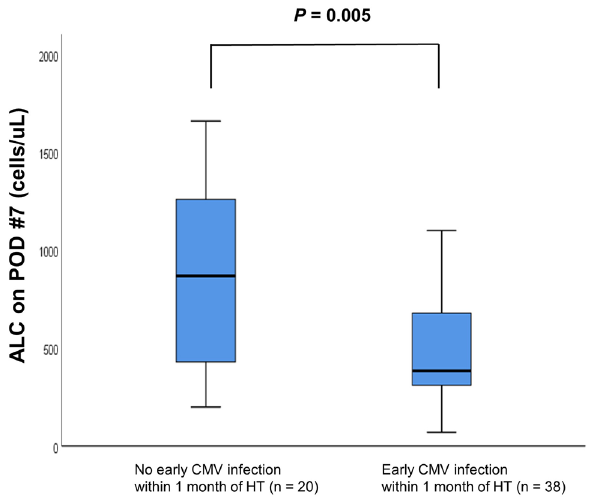
Figure 2. Distribution of ALC on postoperative day 7 in patients who had early CMV infection within one month after HT (n = 38), and those who did not (n = 20). ALC = absolute lymphocyte count, CMV = cytomegalovirus, HT = heart transplantation.